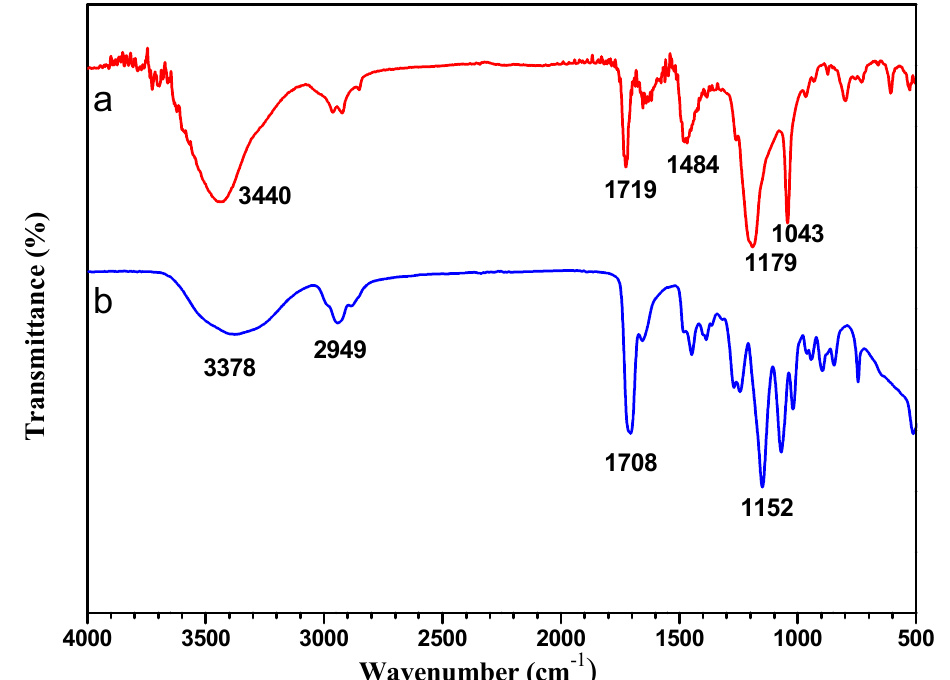
Figure 1. FTIR spectra of PSBMA nanogels ( a ) and pHEMA contact lens ( b ).